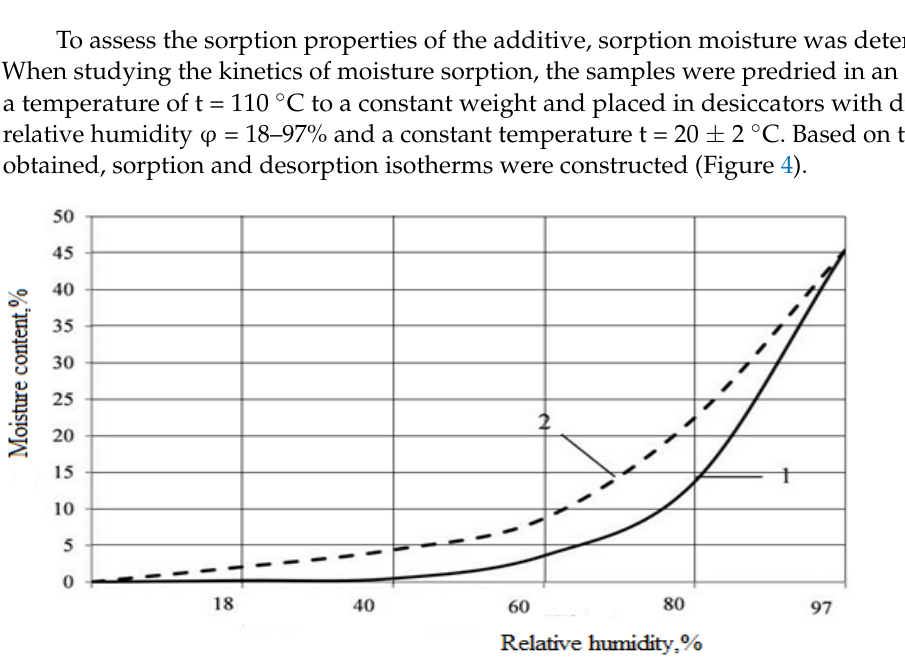
Figure 4. Sorption and desorption isotherms of an additive based on synthetic aluminosilicates: 1 — sorption isotherm; 2 — desorption isotherm.